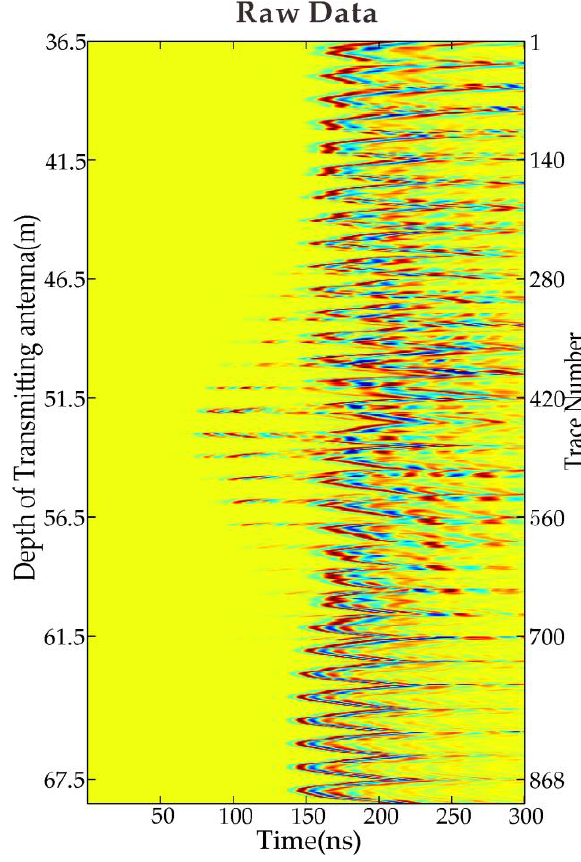
Figure 8. Measured cross-hole radar raw data at Xiuyan mine.